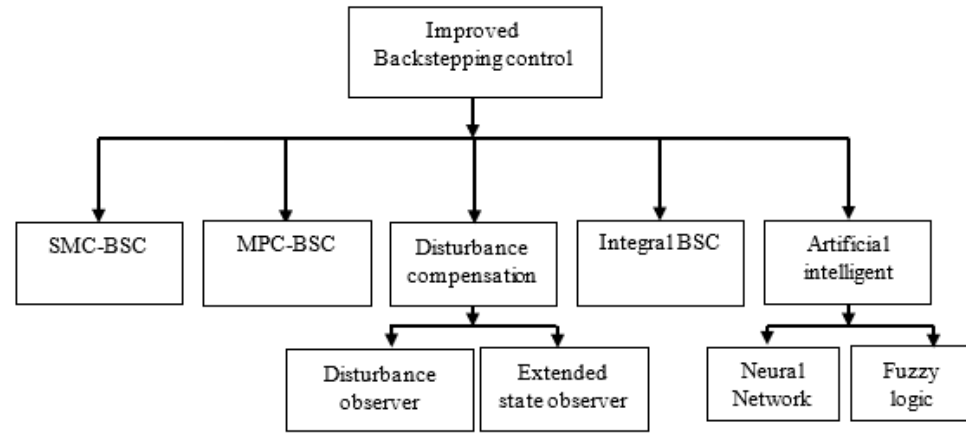
Figure 10. Summary of BSC enhancement techniques.